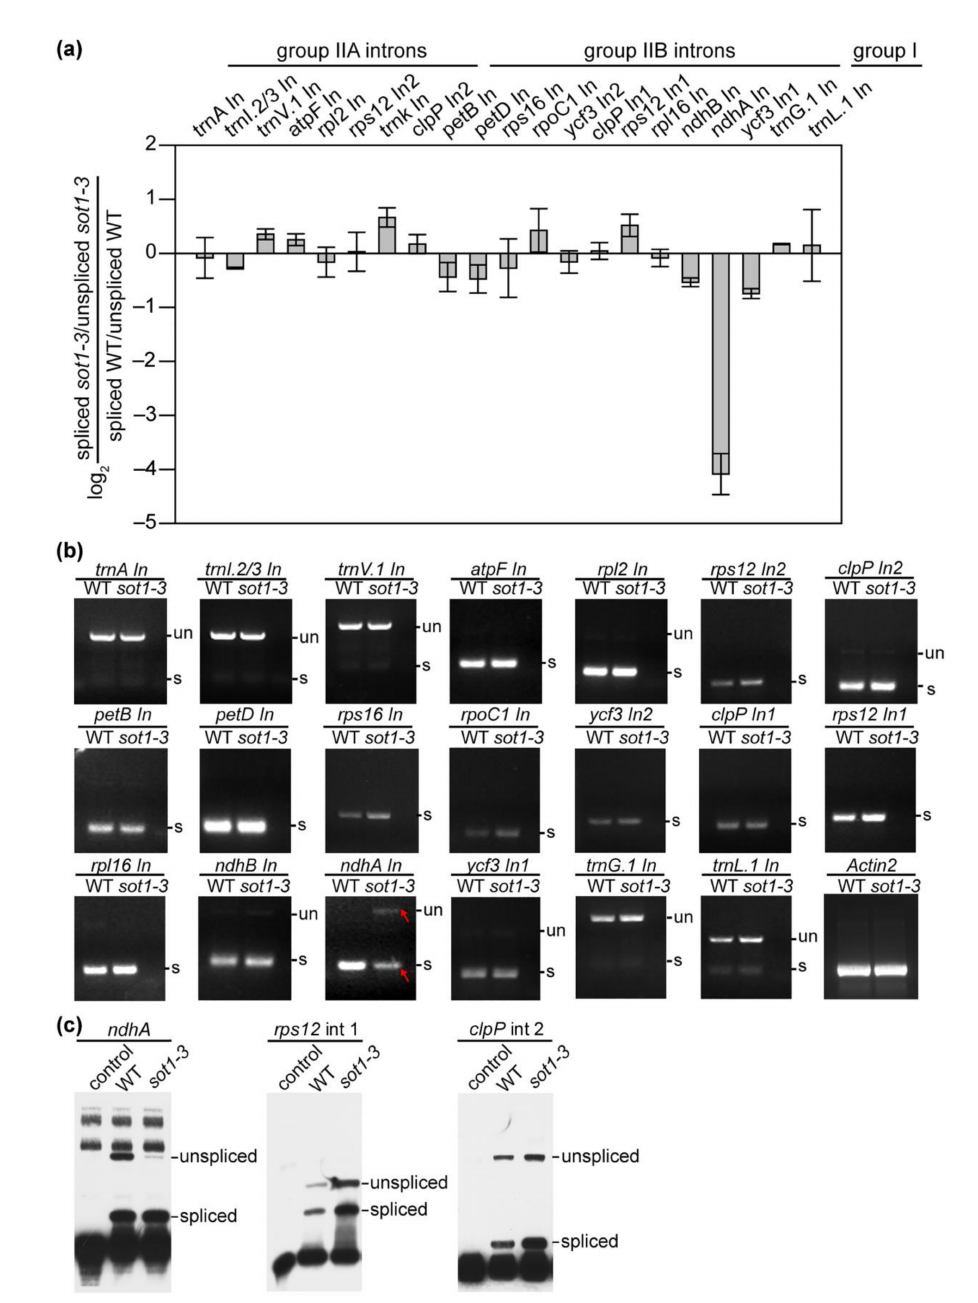
Figure 8. SOT1 is required for the splicing of the ndhA intron. ( a ) qPCR analysis of the splicing efficiency of chloroplast introns. The values represent the difference in the ratios of spliced to unspliced transcripts in 12-day-old sot1-3 seedlings compared with the wild type. Four biological replicates were analyzed. Error bars indicate SD. ( b ) Reverse transcription (RT)-PCR analysis of all intron-containing plastid genes in total leaf RNA from the WT and sot1-3 . Primers flanking each plastid intron were used, as shown in Supplementary Table S2. The bands of ndhA intron in sot1-3 are highlighted in red. un, unspliced transcripts; s, spliced transcripts. ( c ) Poisoned primer extension analysis of the splicing efficiency of ndhA . Biotin-labeled DNA primers complementary to the exon sequences near the splice junction were used to initiate reverse transcription in the presence of a dideoxynucleotide that terminates the extension after different distances on spliced and unspliced transcripts. The poisoned primer extension assays for rps12 intron 1 and clpP intron 2 were used as